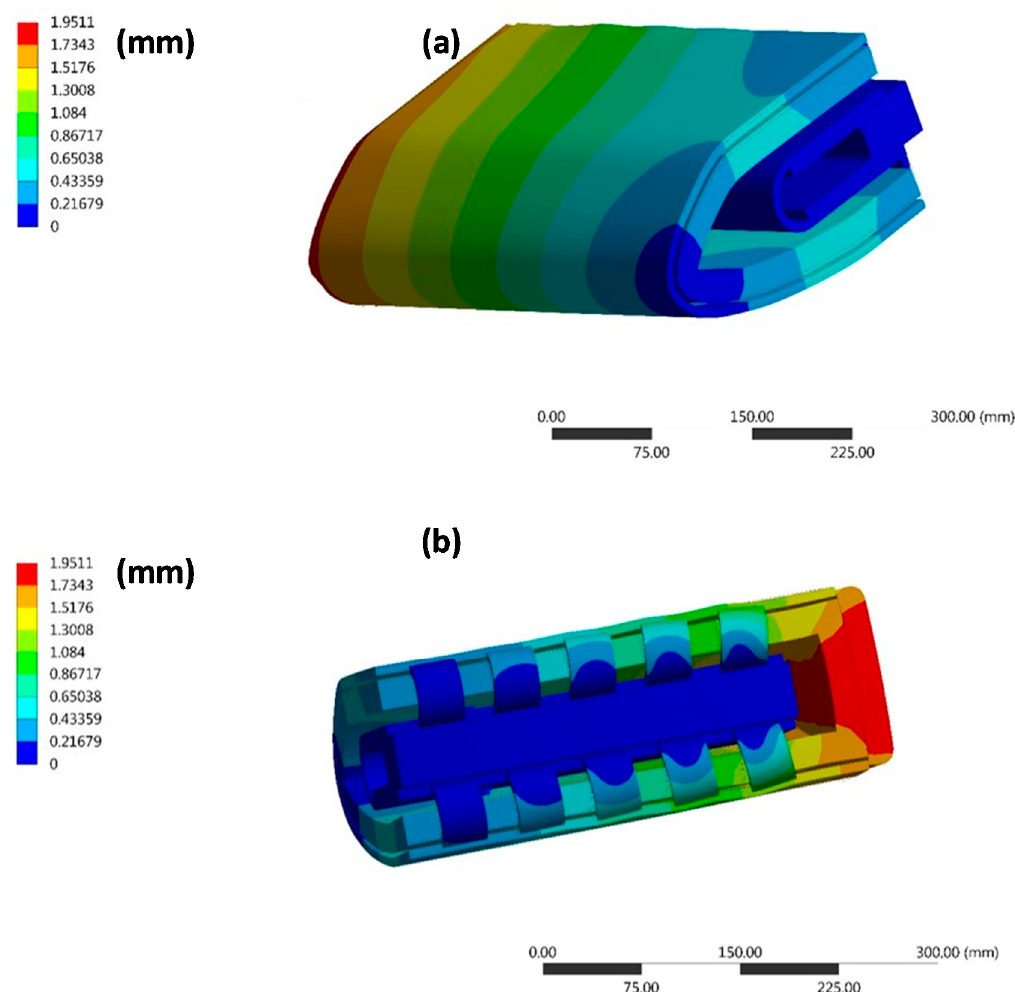
Figure 8. Displacements (magnitude) at 1200 seconds - Global coarse shell model: ( a ) front view; ( b ) rear view – Amplification factor: 7.